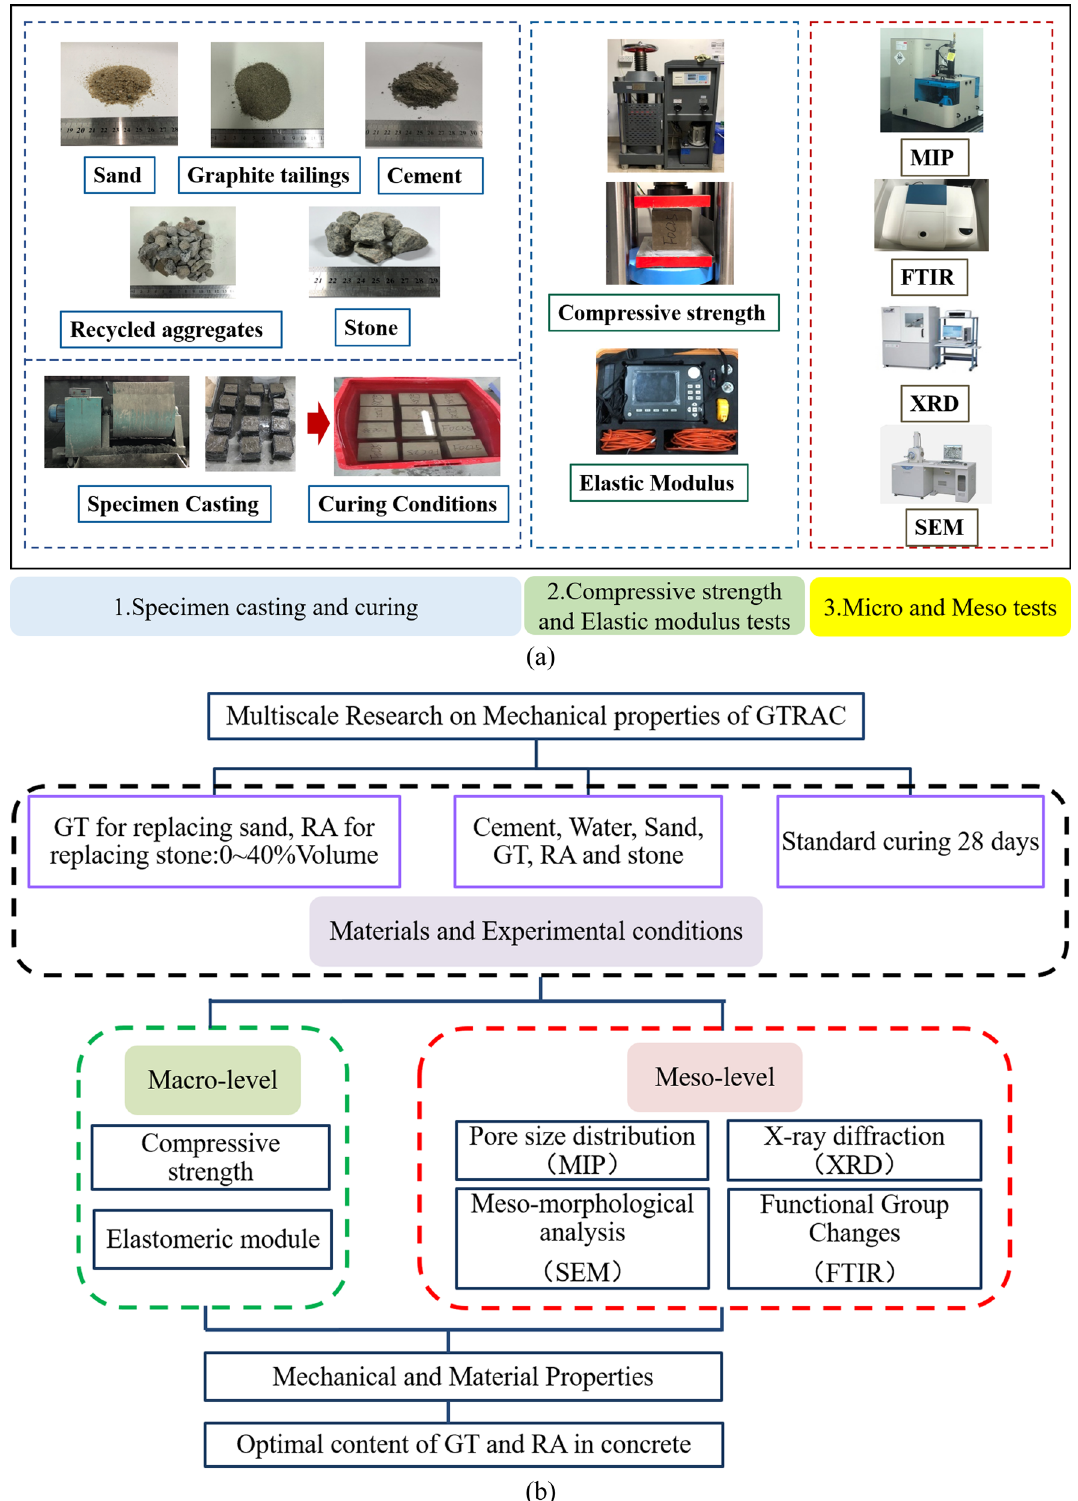
Figure 1: ( a ) Experimental fl owchart; ( b ) research fl